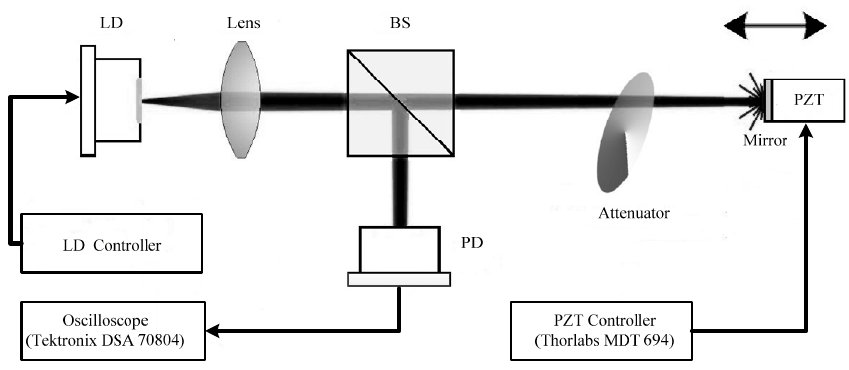
Figure 3. Experimental setup.